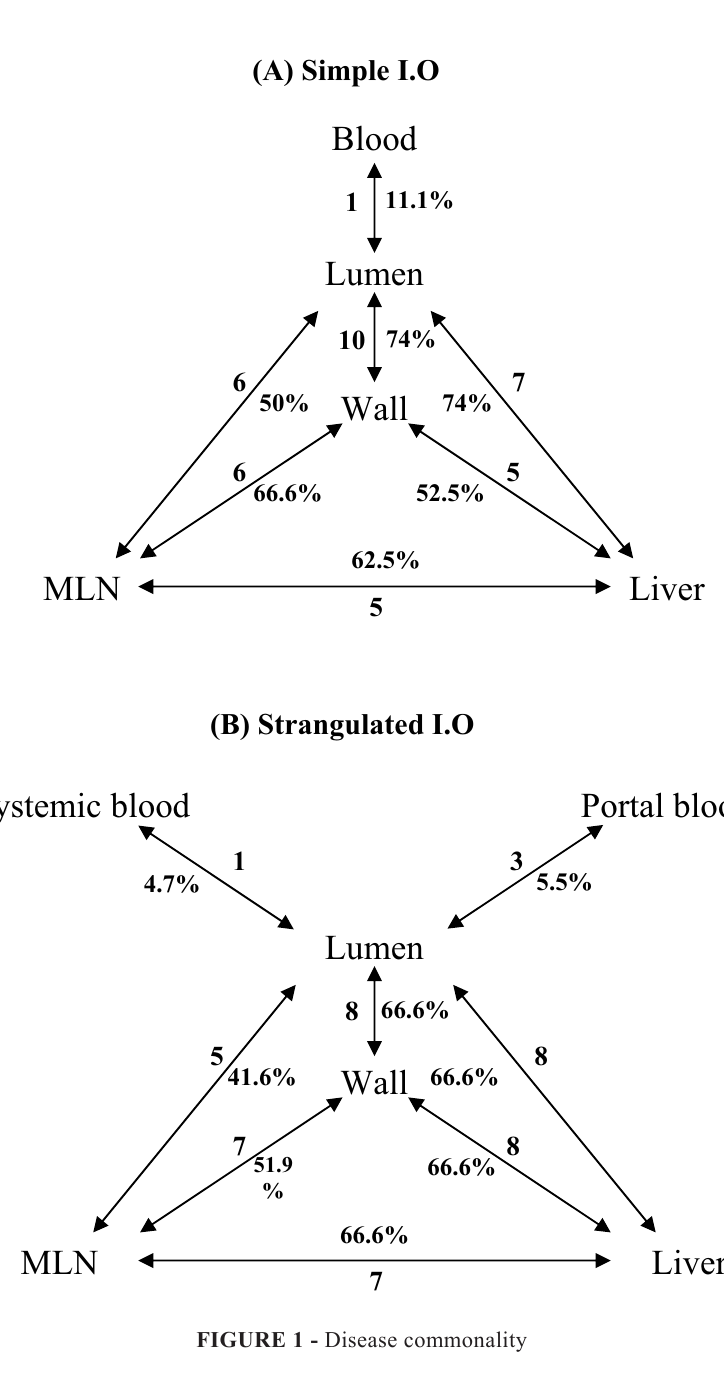
FIGURE 1 - Disease commonality